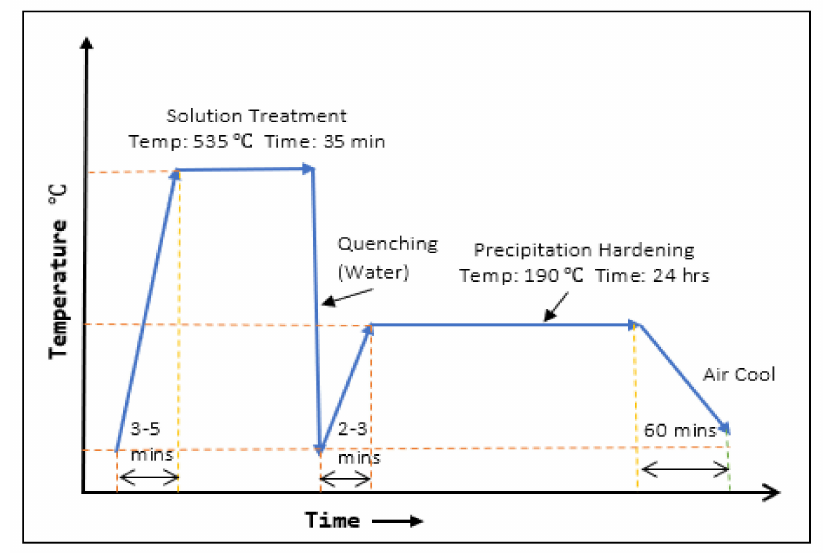
Figure 1. Heat-treatment cycle for T6